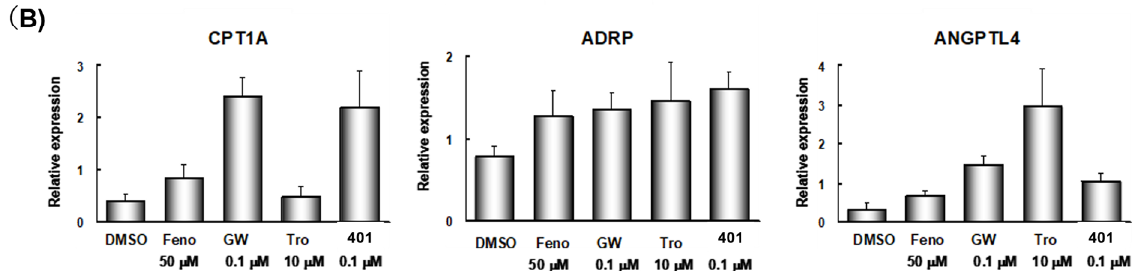
Figure 8. ( A ) Nuclear receptor cross-reactivity of 0.1 µ M, and 1 µ M TIPP-401. ( B ) Regulation of expression of representative PPAR-targeted genes by various PPAR ligands.